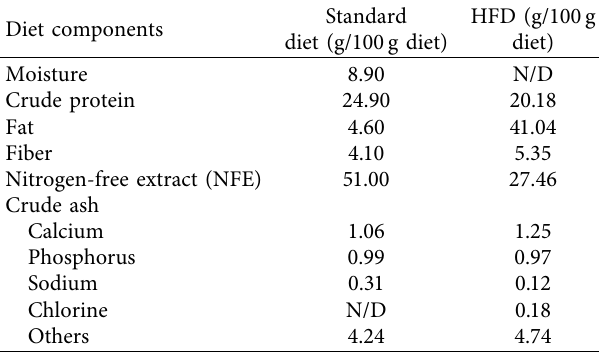
Table 1: Formulations of standard diet and high-fat diet (HFD). Diet